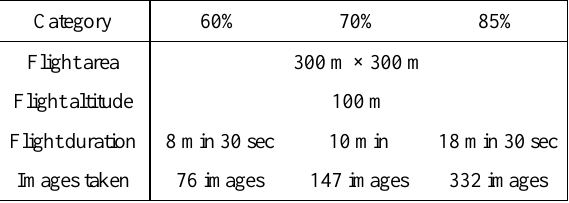
Table 2. Nadir photographing records with different overlapping